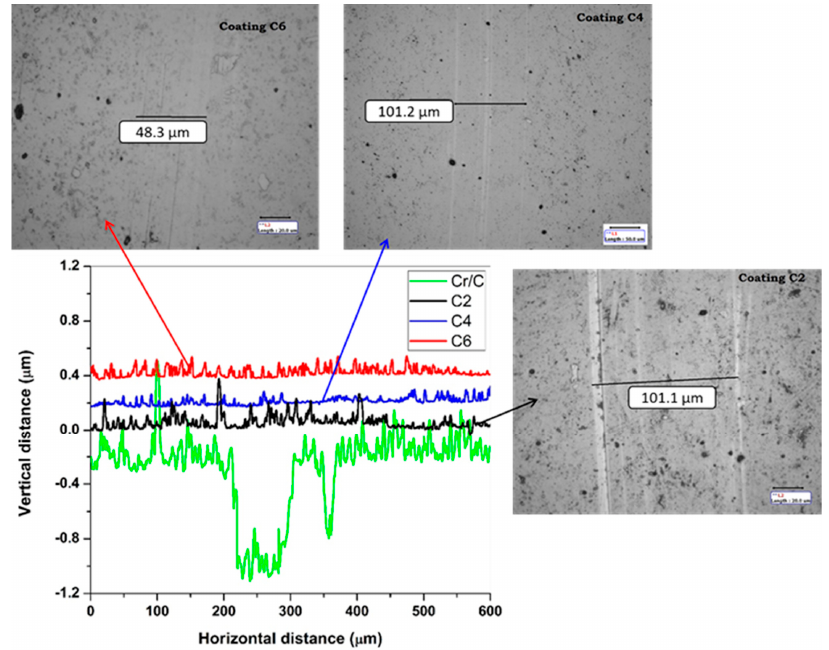
Figure 12. Wear-track profiles of C2, C4 and C6 after lubricated sliding at ambient temperature (Cr/C coating is used as a reference).